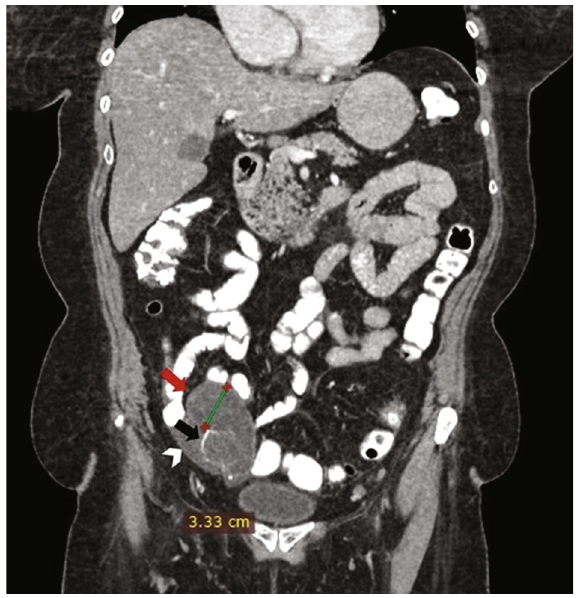
Figure 1: Coronal CT: located in the anatomic region of the right iliac fossa, a low-attenuation cystic lesion that measures 3 : 3cm × 6 : 5 cm with asymmetric wall thickening (red arrow) and focal calci fi cation (black arrow). Peritumoral ascitic fl uid can be detected (white arrow).